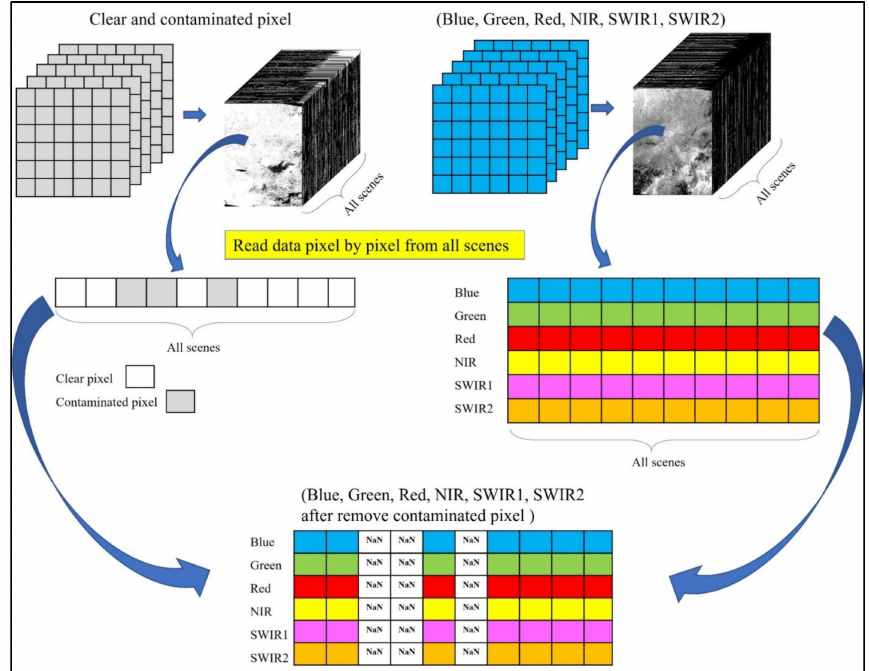
Figure 4. Time-series spectral reflectance